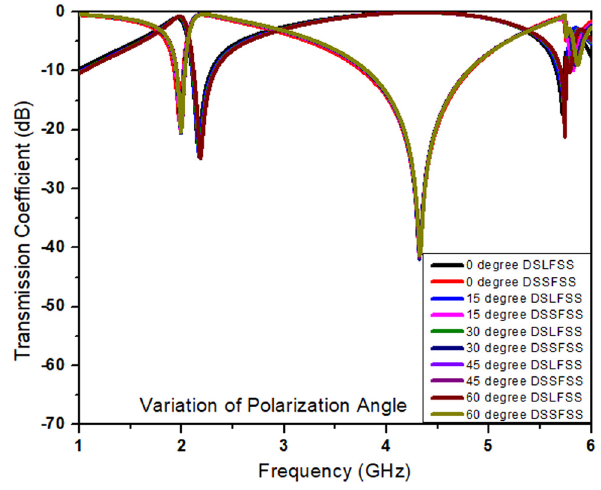
Figure 9: Transmission coe ffi cient of the CPFSS structure at di ff erent polarization angles.